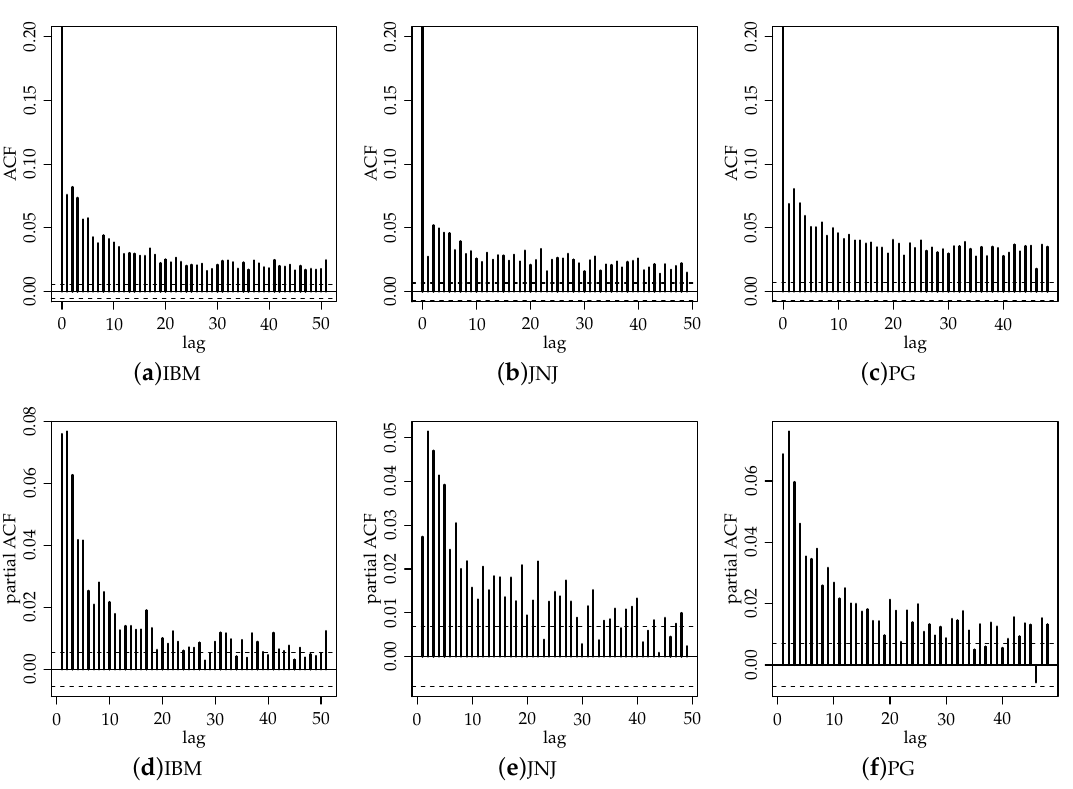
Figure 2. Autocorrelation and partial autocorrelation functions for the indicated data sets.